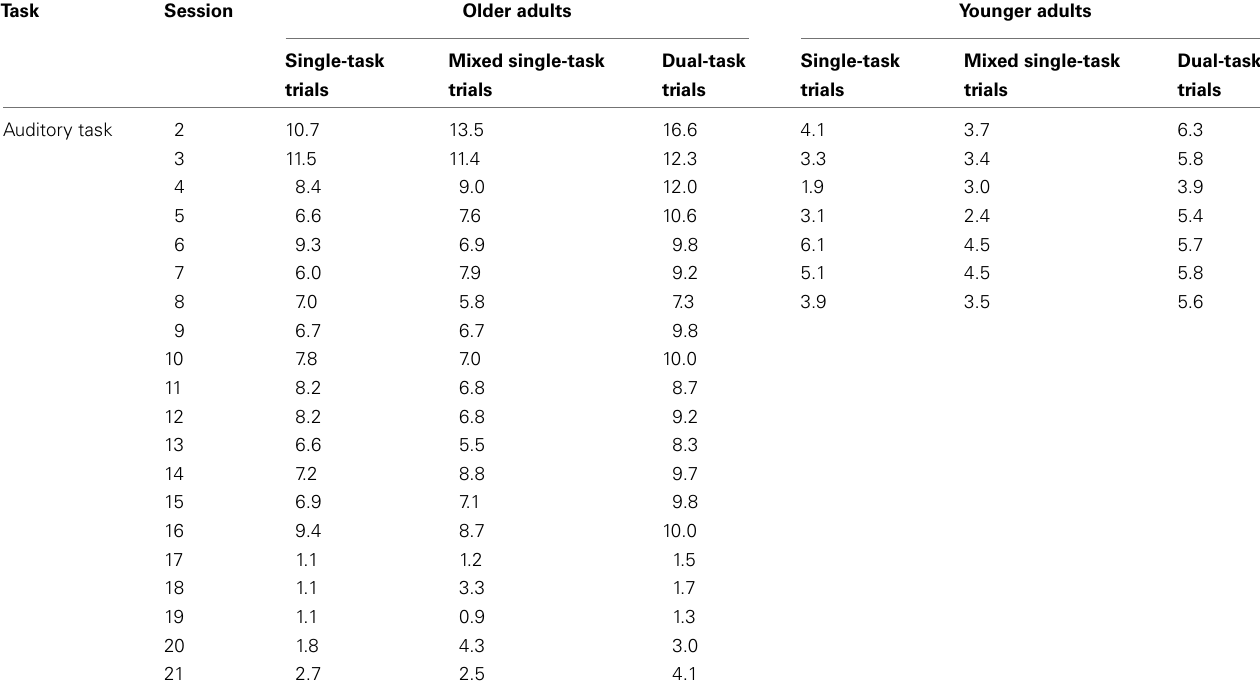
Table 2 | Error rates in percent in single-task trials of single-task blocks, single-task trials in mixed blocks (mixed single-task trials), and dual-task trials for the auditory task in older and younger adults across Session 2–21 (older adults) or Session 2–8 (younger adults).